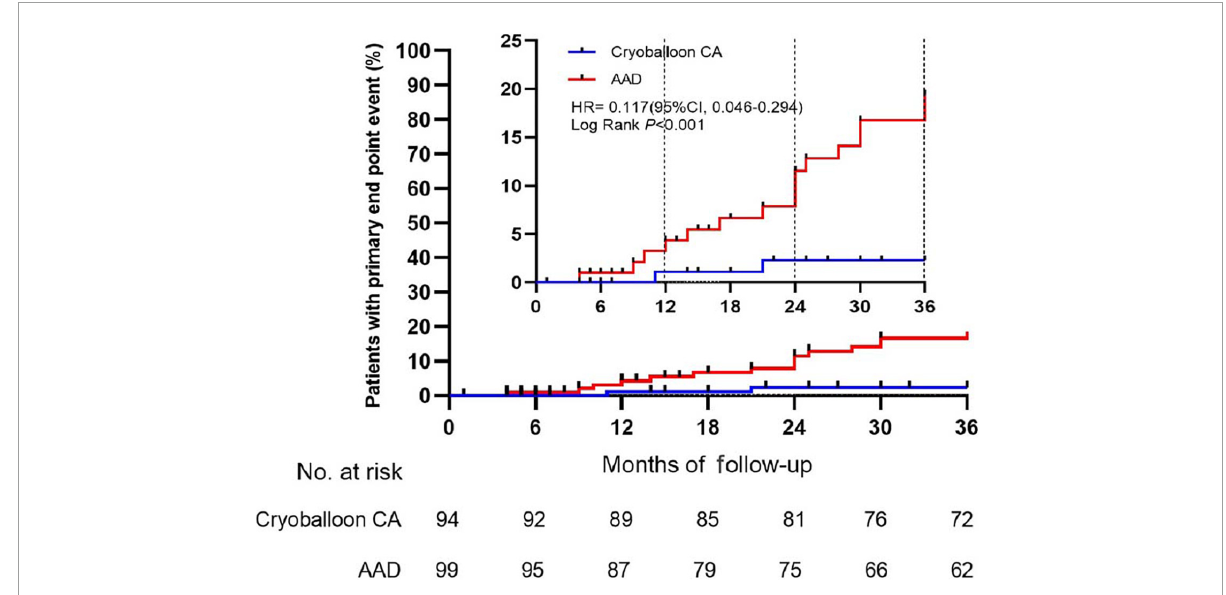
FIGURE3 Time to the occurrence of persistent atrial tachyarrhythmia in the per-protocol cohort. CA, catheter ablation; AAD, anti-arrhythmic drug.